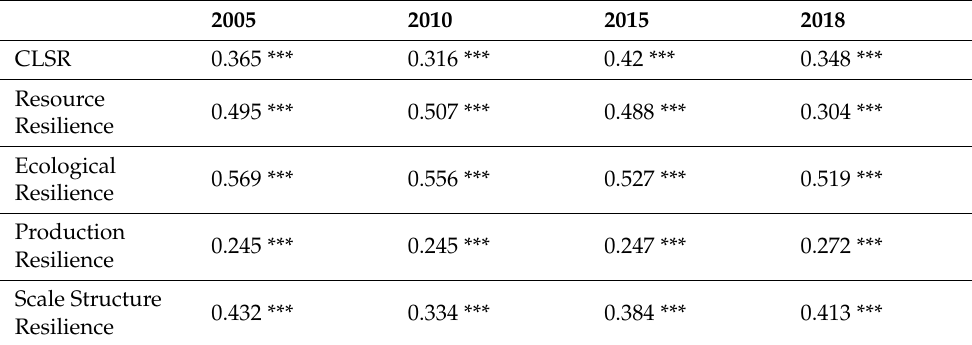
Table 3. Spatial Correlation of Cultivated Land Use System Resilience